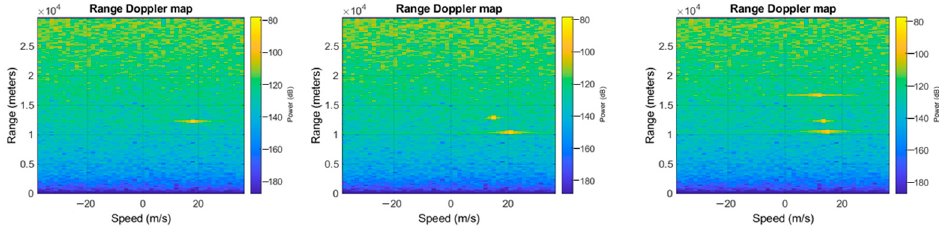
Figure 6. Example of range-Doppler maps generated with fixed positions at different speeds of (re- spectively, from the left to right) 1, 2, 3 targets. Figure 7. Example of range-Doppler maps generated with speeds of 225 m/s and different positions of (respectively, from the left to right) 1, 2, 3